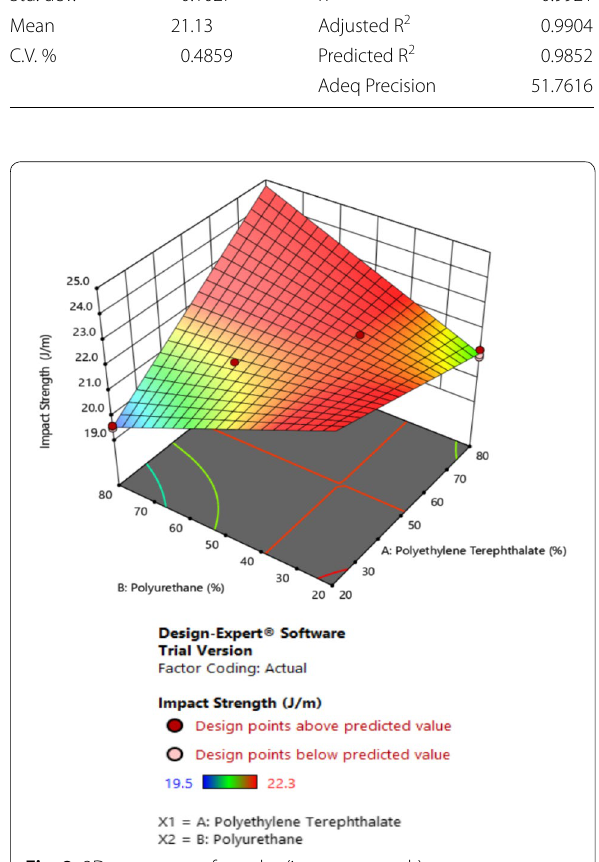
Fig. 8 3D response surface plot (impact